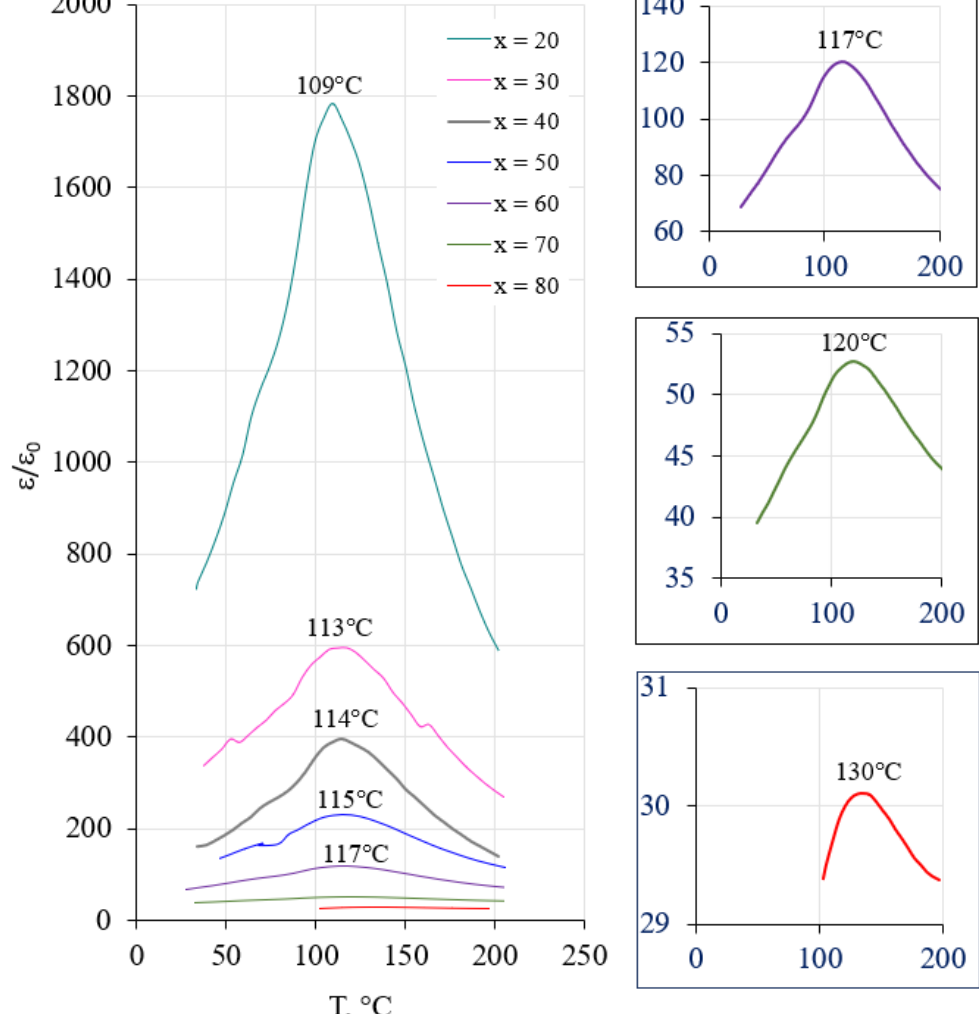
Figure 6. The dielectric constant temperature dependences of (100 − x) wt.% BCZT + x wt.% NCCMF composite ceramics at a frequency of 1 MHz.